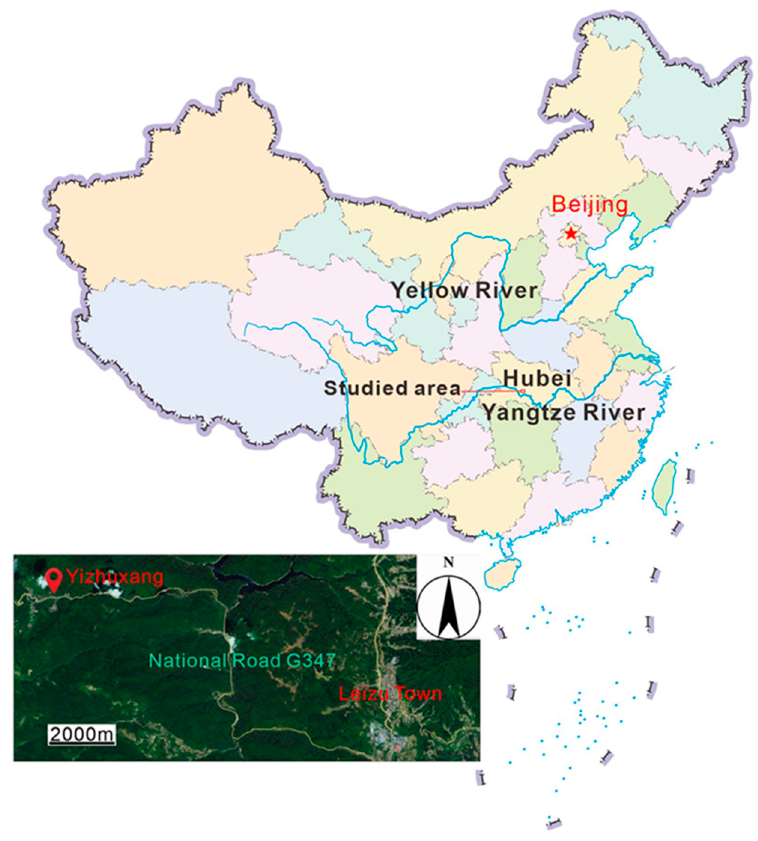
Figure 1. Stable geographical location of the rock mass Yizhuxiang.